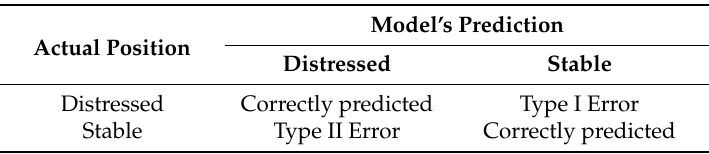
Table 3. Type of